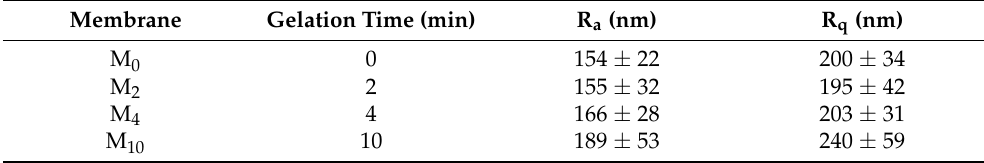
Table 2. Surface roughness results concerning PA6 membranes for the 5 µ m × 5 µ m scanned